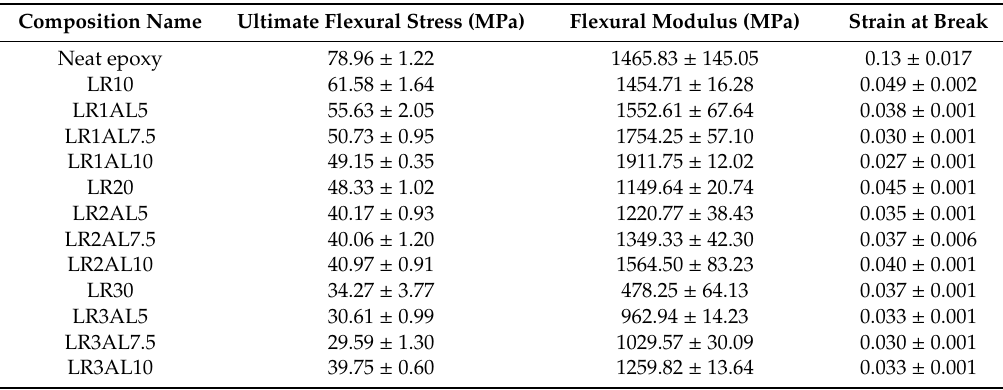
Table 3. Mechanical properties of the tested